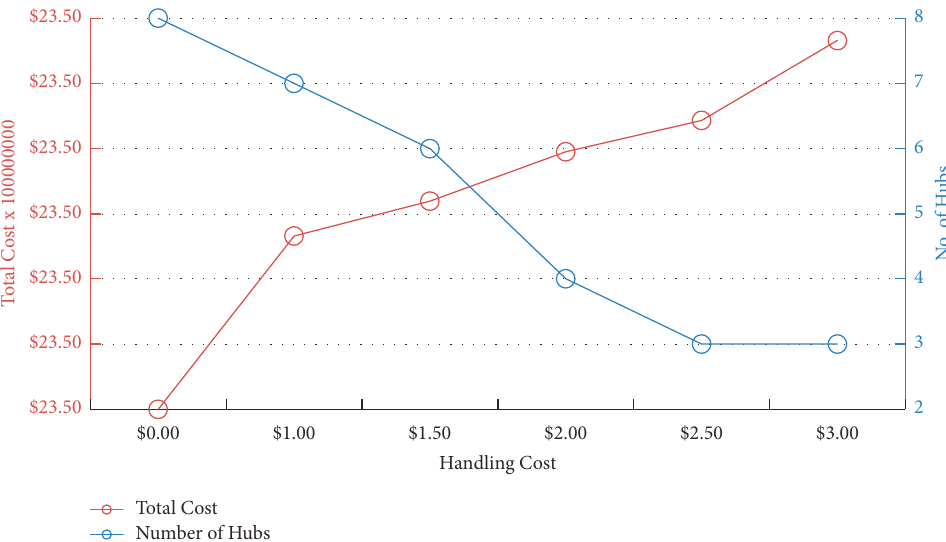
Figure 9: Impact of handling cost, total cost, and no. of